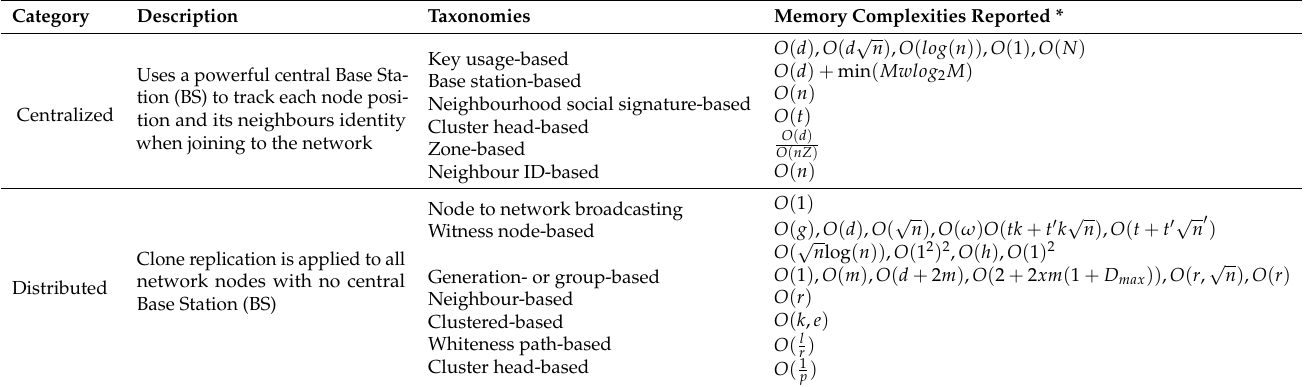
Table 3. Centralized and distributed techniques for corrective controls in the detection of Clone ID